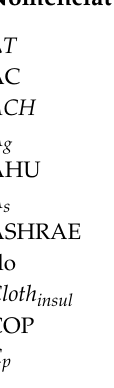
Figure S1: Annual electricity consumption (kWh) of di ff erent AC